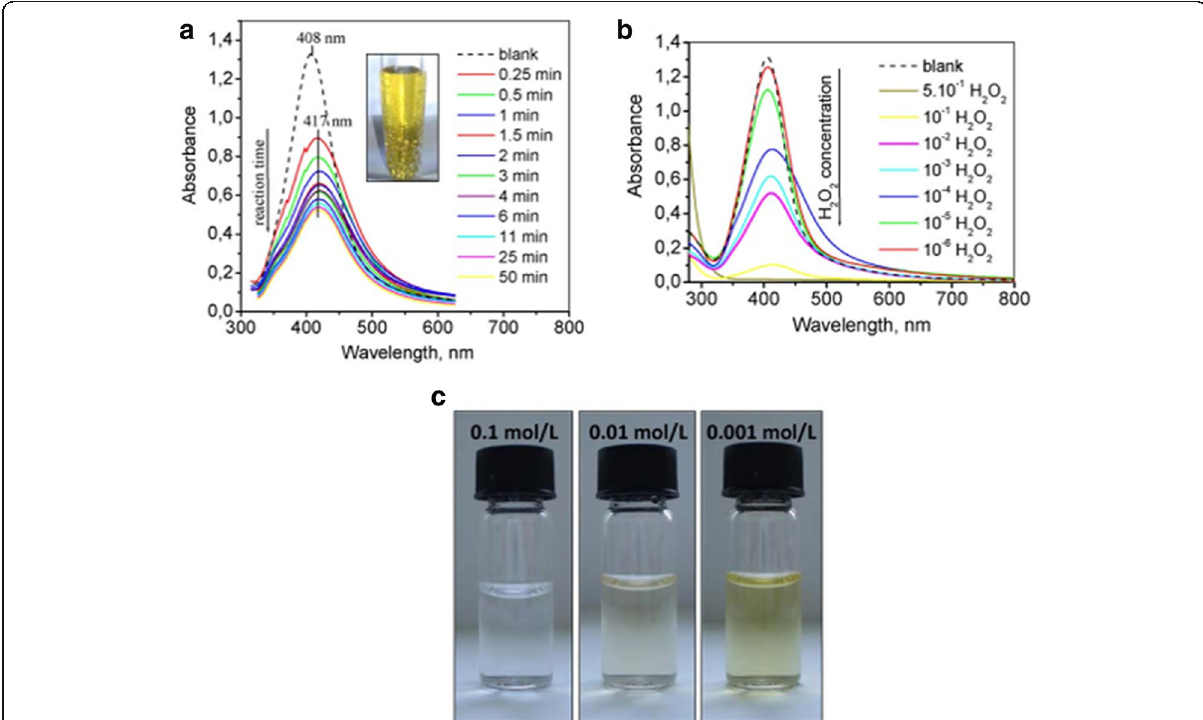
Fig. 19 a Change of the LSPR absorbance strength with time due to the introduction of 10 – 3 mol/L H 2 O 2 solution in the as-synthesized Ag-NPs solution at a volume ratio 1:1.5; the inset shows the bubbles from H 2 O 2 decomposition generated by the catalytic reaction between hydrogen peroxide and starch-stabilized Ag-NPs. b UV-vis absorption spectra recorded 15 min after the introduction of hydrogen peroxide solution with different concentrations in the solution of Ag-NPs at a volume ratio 1:1.5. c relevant photographs of Ag-NPs dispersions 60 min after the introduction of hydrogen peroxide with different concentrations